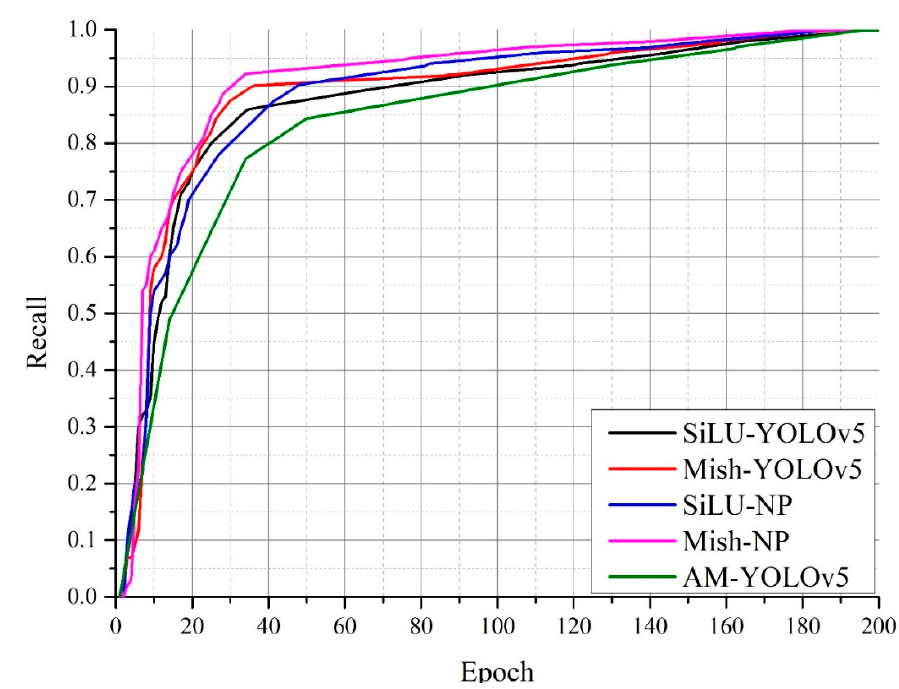
Figure 10. Comparison of the recalls of the algorithms.